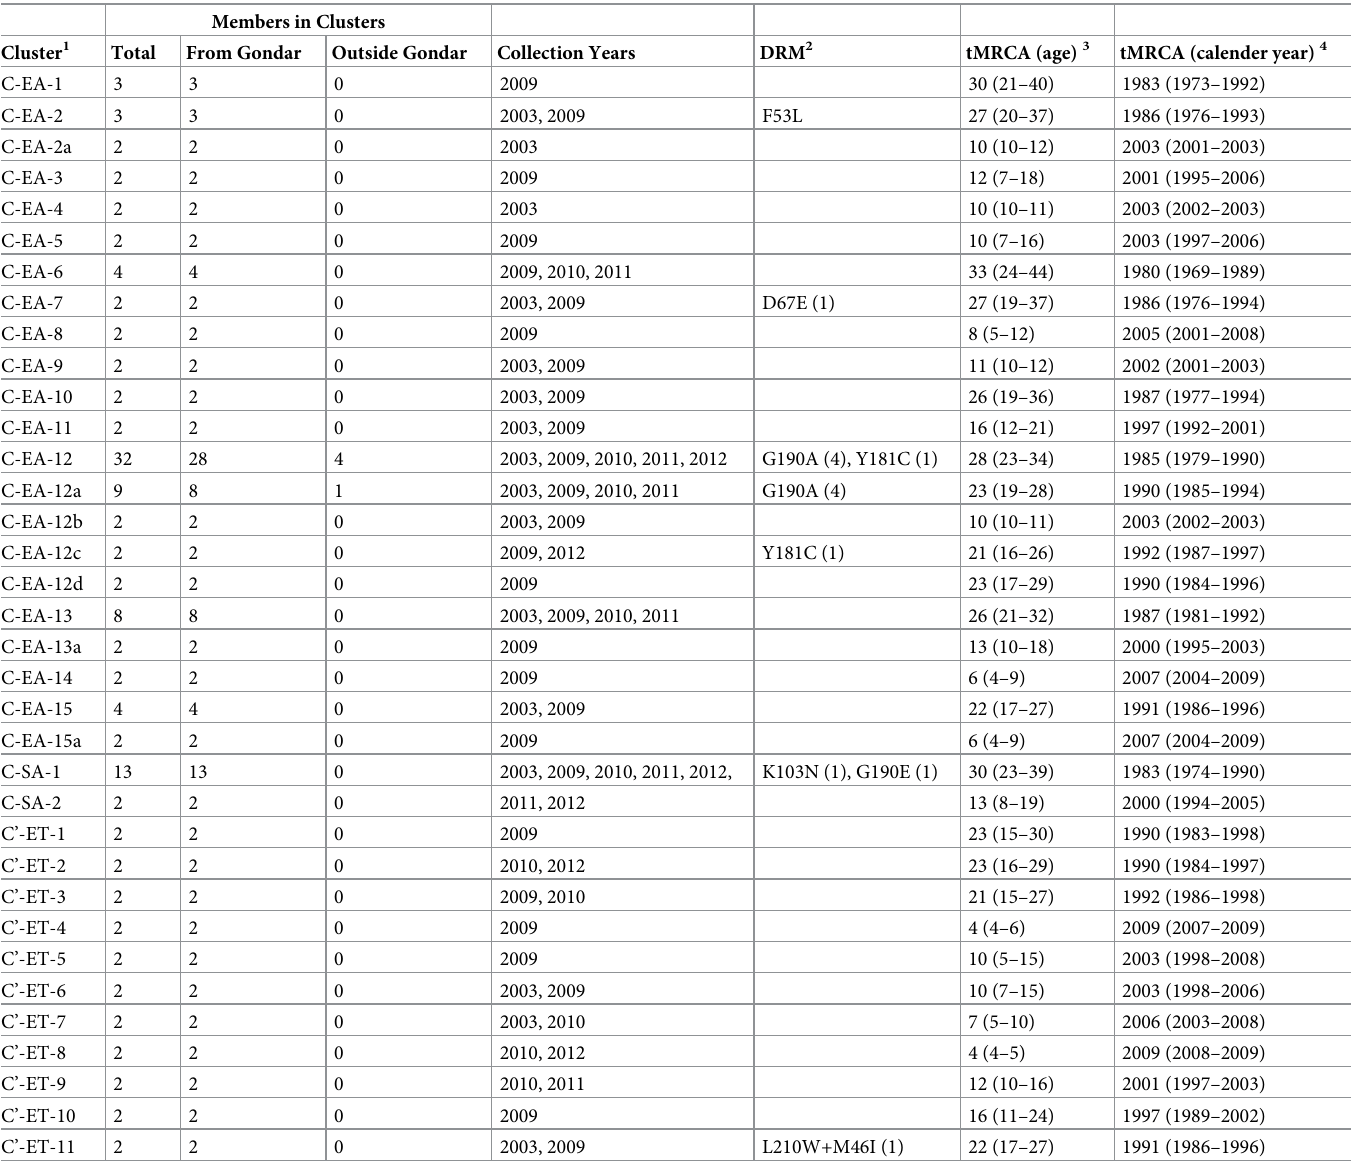
Table 2. Characteristics of Gondar transmission